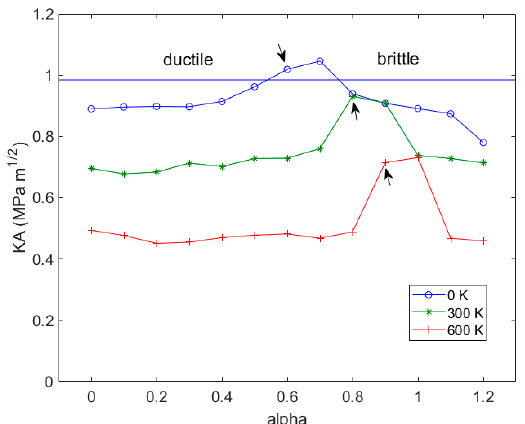
Figure 12. Comparison of the threshold values of the applied stress intensity K A at temperatures of 0 K, 300 K and 600 K. The arrows denote the ductile-brittle transition. The data for 0 K are taken from [6].